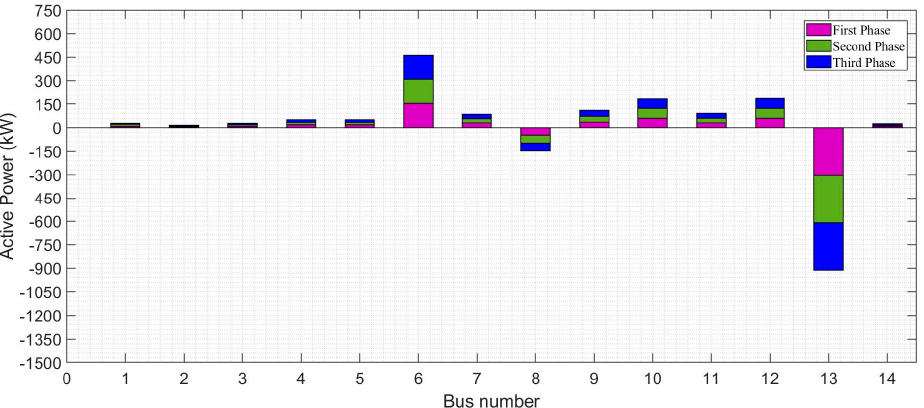
Figure 13. The minimum demand power balance.